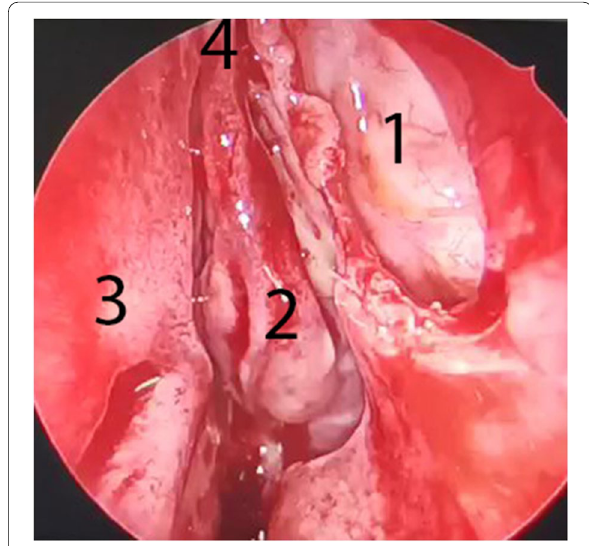
Fig. 3 Marsupialized lacrimal sac with a wide opening into the nasal cavity. 1 marsupialised sac, 2 middle turbinate, 3 nasal septum, 4 axilla of middle